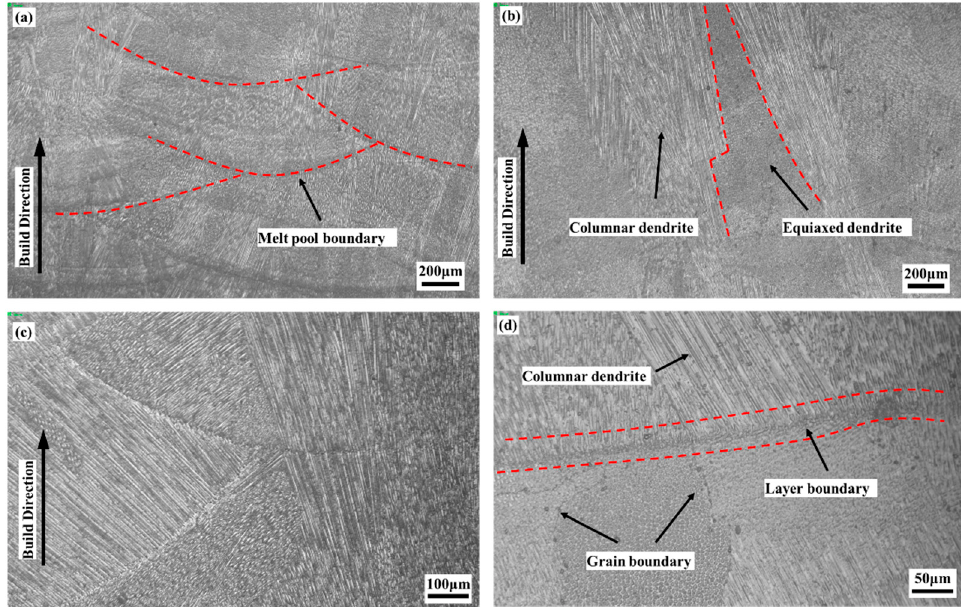
Figure 3. Macrostructure of different sections of the deposited Inconel 690 samples: ( a ) YZ; ( b ) XZ; ( c ) YZ enlarged; ( d ) XZ enlarged. ( c ) YZ enlarged; ( d ) XZ